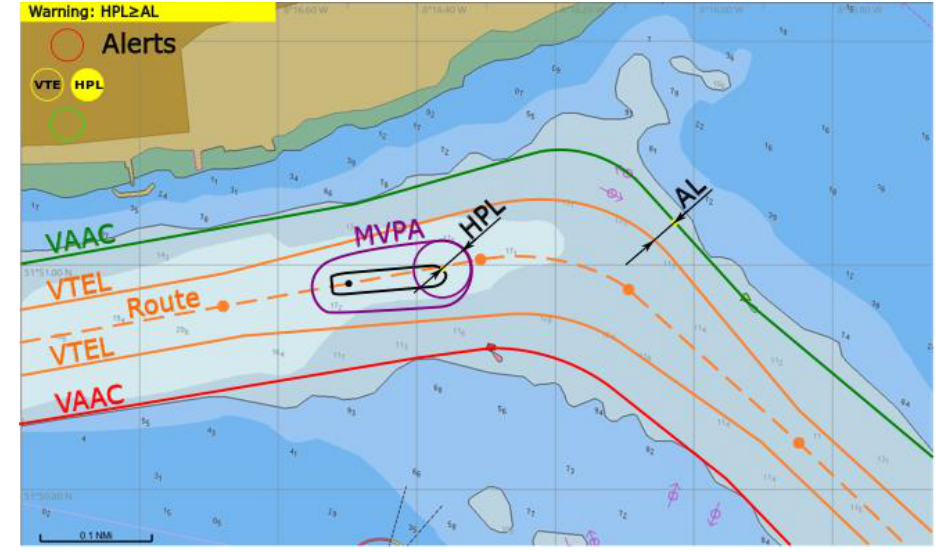
Figure 10. Warning of HPL raised, conceptual presentation in ECDIS.